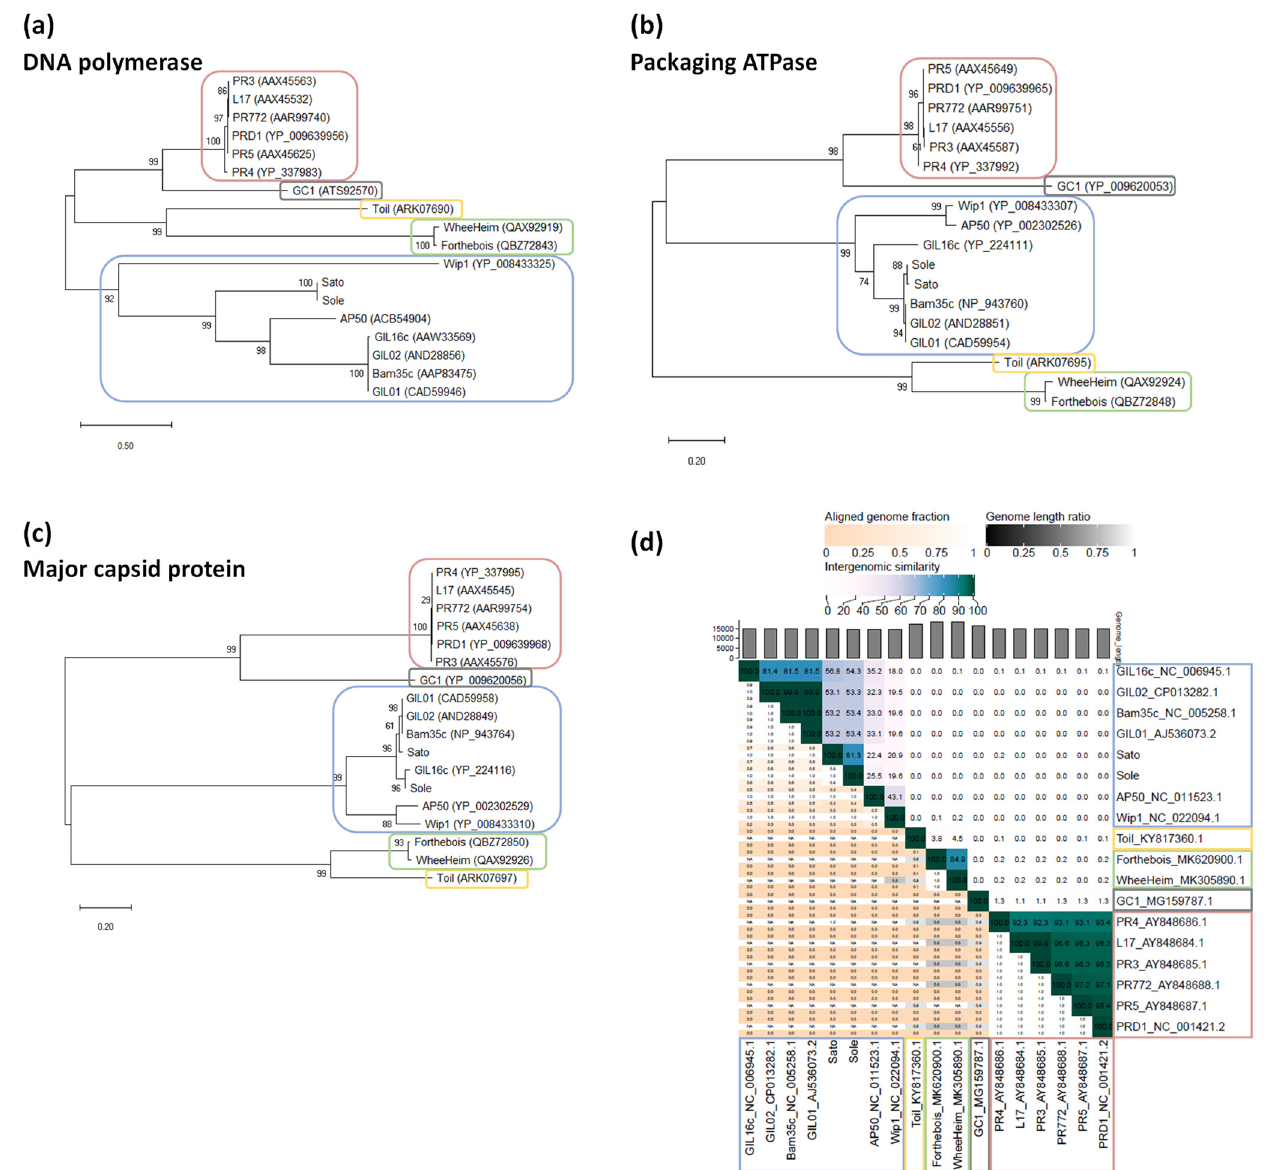
Figure 4. Phylogenetic relationships of phages Sato and Sole with other phages within the family Tectiviridae . ( a – c ) Phylogenetic trees resulting from maximum likelihood inference on multiple amino acid sequence alignments of the three canonical tectiviral proteins: the DNA polymerase ( a ), packaging ATPase ( b ), and major capsid protein ( c ). The general reverse transcriptase model was used to compute the maximum likelihood trees. Bootstrap values (1000 iterations) above 60% are indicated for each node. Scale bars in ( a – c ) represent the numbers of substitutions per site. Protein GenBank accession numbers are indicated in parentheses. ( d ) Virus Intergenomic Distance Calculator (VIRIDIC) [42] generated heatmap incorporating intergenomic similarity values (right half) and alignment indicators (left half and top annotation). Phage genome GenBank accession numbers are indicated. Color boxes ( a – d ) highlight phages belonging to genera Alphatectivirus (rose), Betatectivirus (blue), Gammatectivirus (grey), Deltatectivirus (green) and Epsilontectivirus (yellow). Note that Forthebois, WheeHeim and Toil are actinophages, isolated from the Gram-positive bacteria Streptomyces scabiei for the two formers [24] and from Rhodococcus opacus for the latter [58].